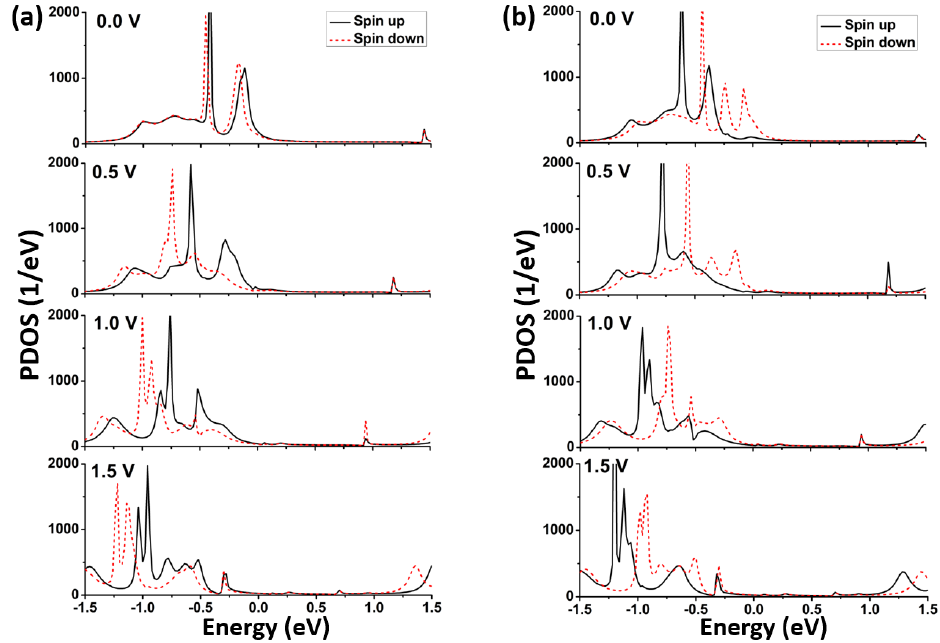
Figure 5. Spin-up and spin-down projected density of states (PDOS) spectra at the different biases for two models: ( a ) M1; ( b ) M2.